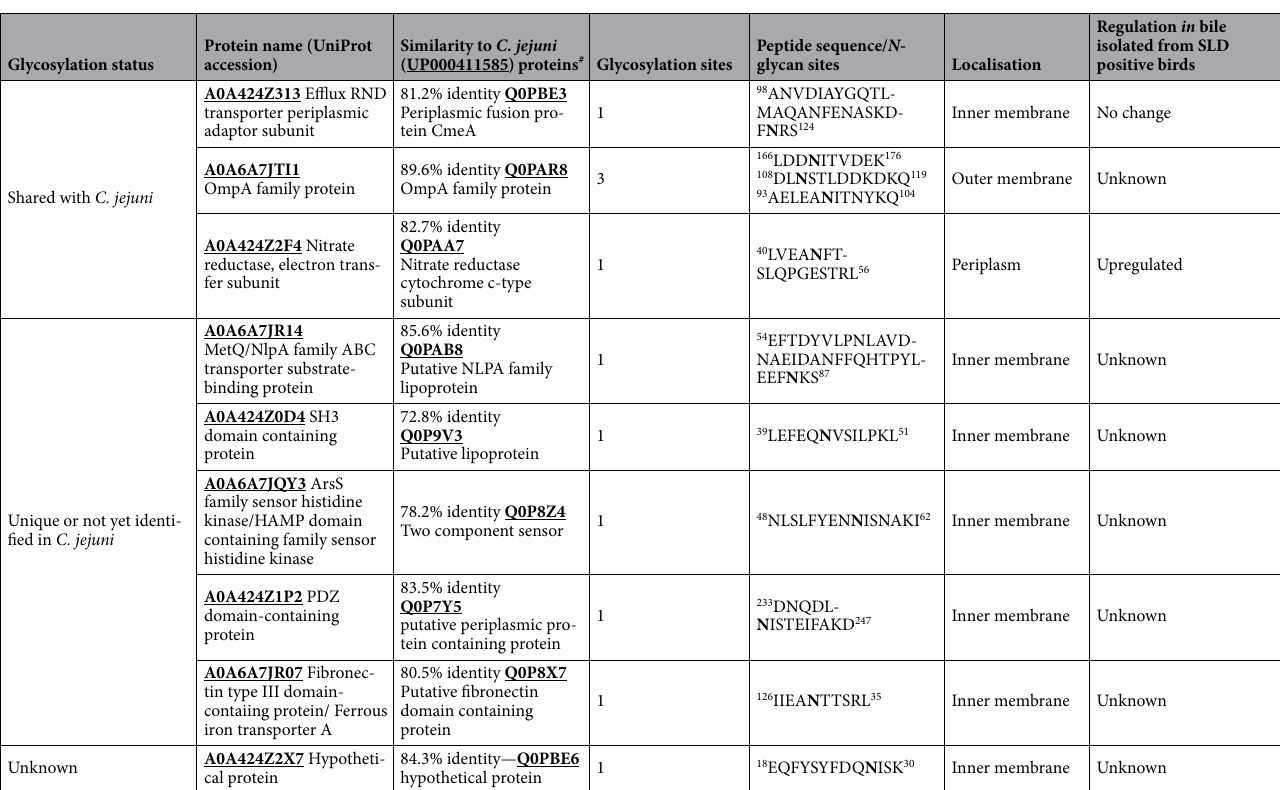
Table 1. N-glycoprotein determinants of C. hepaticus possibly involved in niche adaption and virulence. # Protein identity was determined by NCBI BLAST and Uniprot peptide search; no. of glycosylation sites for each protein; the peptide sequences and N -glycan site (manually assigned) based on consensus sequon D/E-X- N-X-S/T . Localisation was determined using Gneg-mPloc & PSORTb (vers. 3.0.3). In vivo gene regulation of glycoproteins identified were crossed referenced with the findings of Van et al. 7